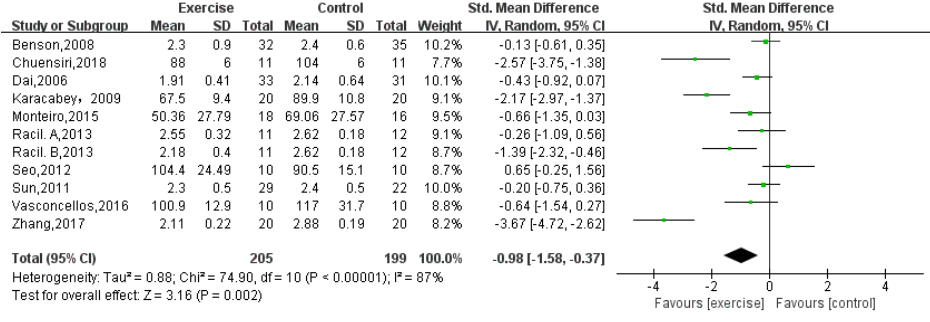
Figure 5. Forest plot of LDL-C.